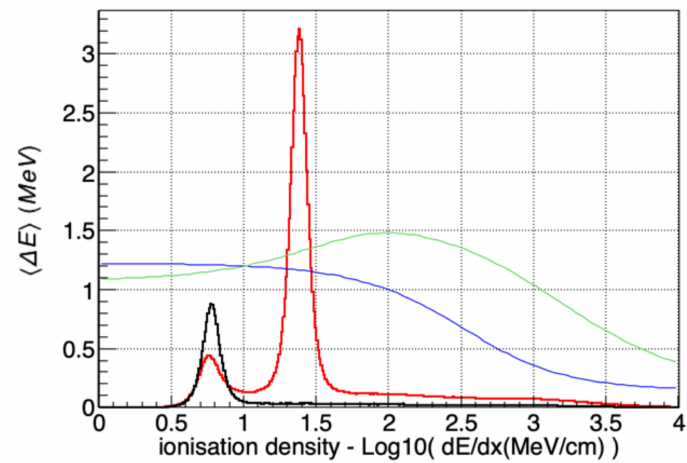
Figure 2. Black and red histograms represent the mean energy deposit for each bin of ionization density due to 100 GeV nonshowering protons and helium in 2 cm of LYSO, respectively. The green and blue curves are the typical luminous efficiencies for alkali and silicate scintillators, reported here in arbitrary units